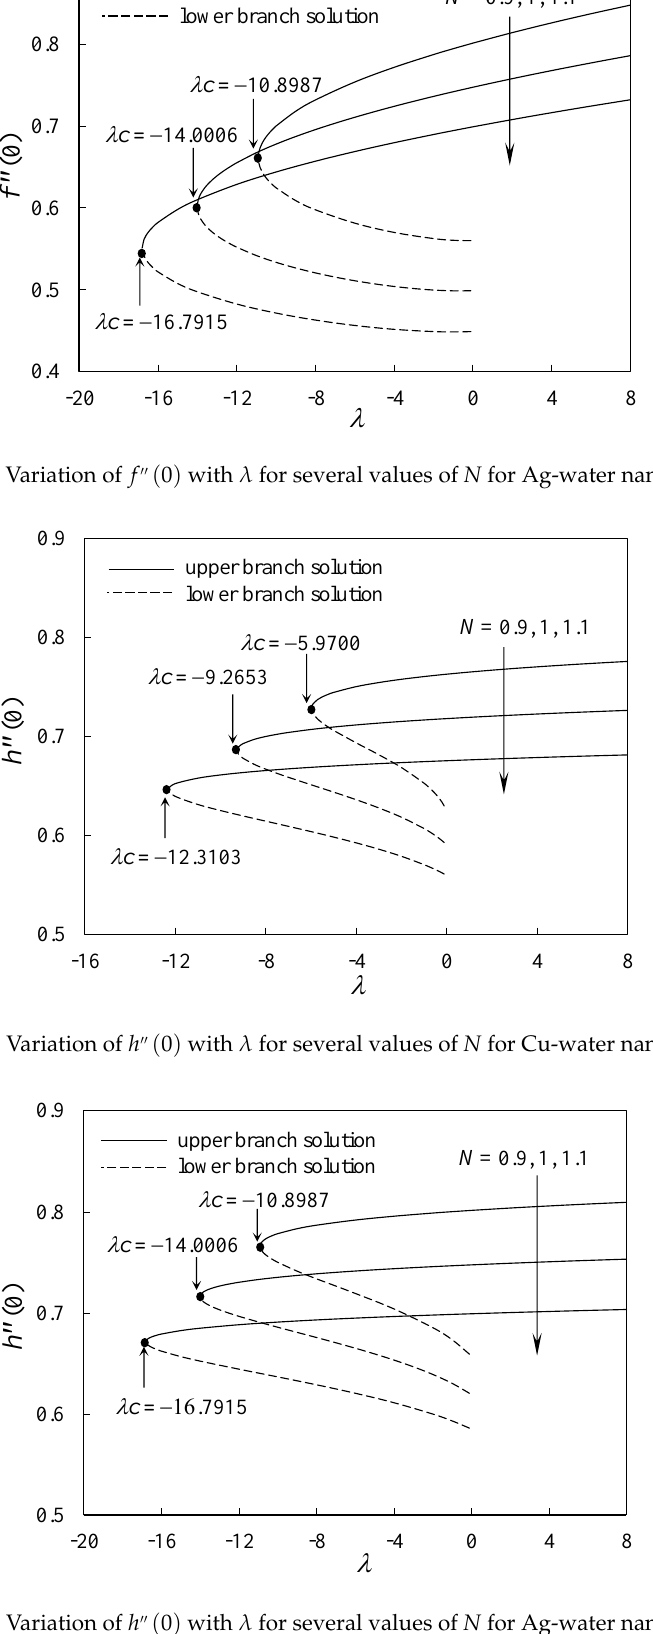
  0 f  with  for several values of N for Cu-water nanofluid.